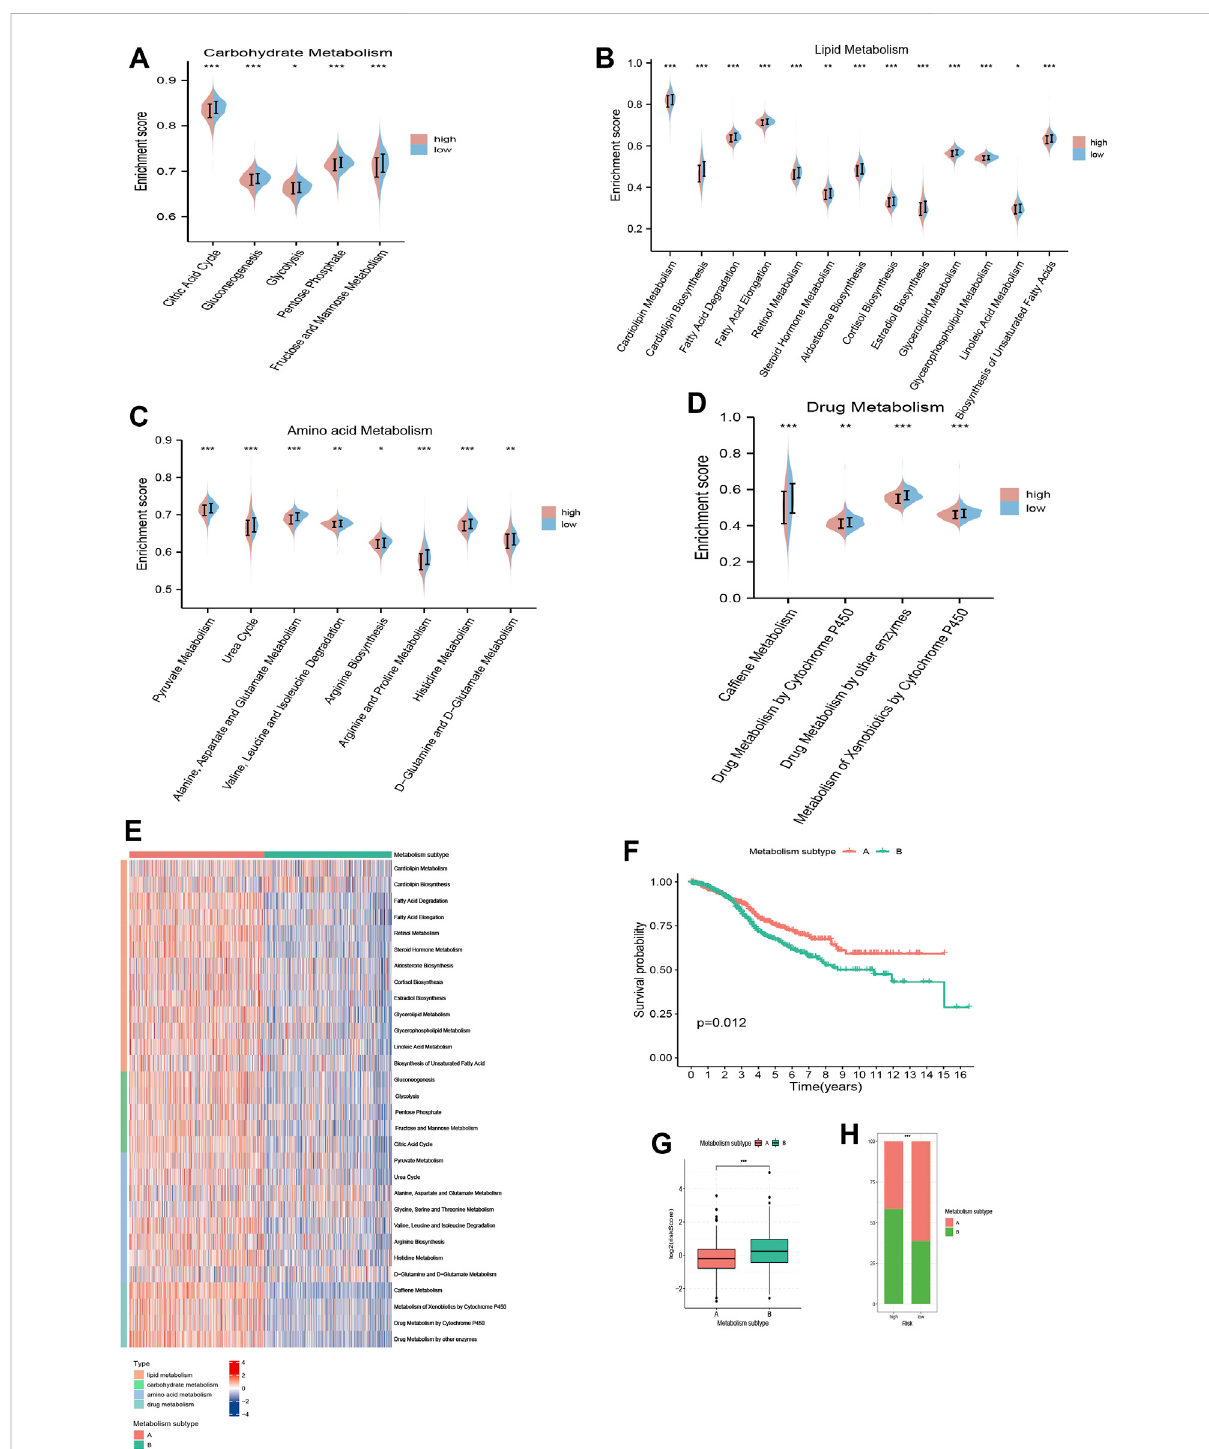
FIGURE 8 Metabolism analysis of TRMRG risk score signature. Violin plots comparing the metabolic activities of (A) carbohydrate, (B) lipid, (C) amino acid and (D) drug between high and low risk patients. (E) Distinctions in metabolic activities between two metabolism subtypes. (F) Kaplan-Meier plot for patients with metabolism subtype A and B. (G) Risk score differences between patients with metabolism subtype A and B. (H) Frequencies of two metabolism subtypes in high and low risk patients. Statistical Signi fi cance: * p < 0.05; ** p < 0.01; *** p < 0.001; ns, not signi fi